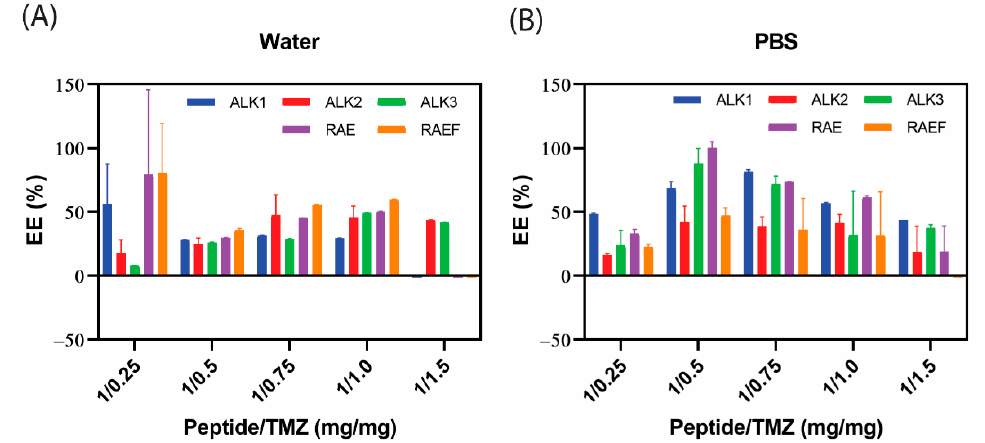
Figure 3. Peptides were prepared and loaded with TMZ using film dehydration and resuspended in either ( A ) water or ( B ) PBS. TMZ concentration was read using UV–vis spectrophotometry and plotted as encapsulation efficiency (%). Data are presented as mean ± SEM (N = 3).